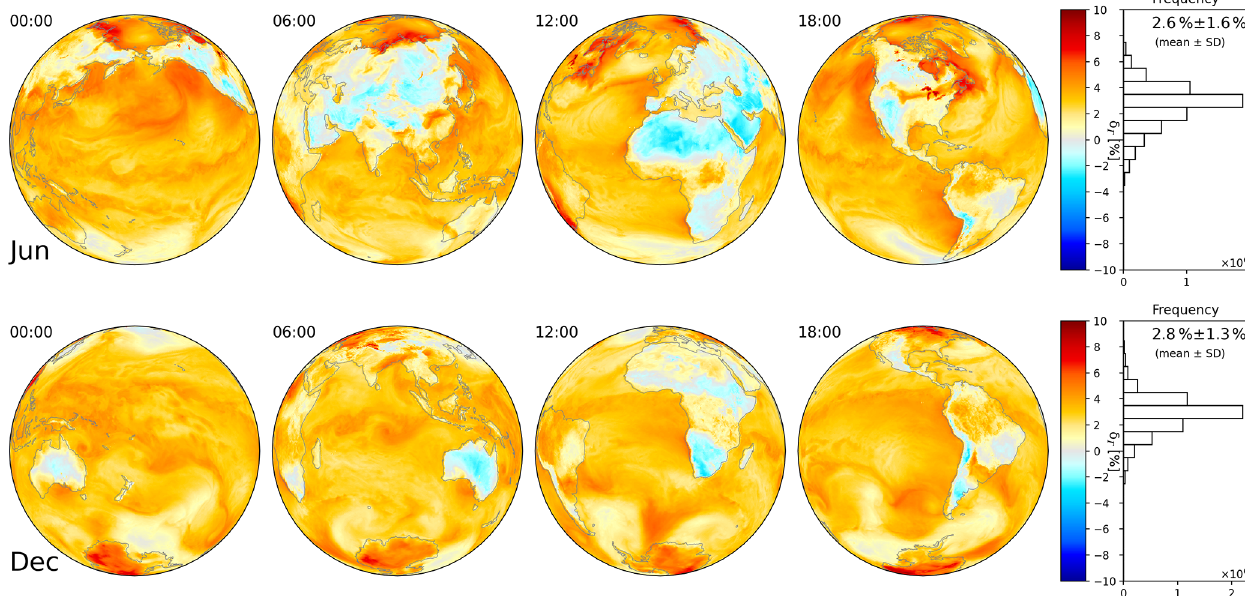
Figure 3. Deviation δ (cid:48) according to Eq. (19) for ERA5 at 00:00, 06:00, 12:00, and 18:00UTC on 18 June (top) and 18 December (bottom) 2018. The projection focuses on daytime for each time step. On the right, the frequency distribution and mean and SD are given for all hourly outputs of the respective day. Results for 18 March and 18 September 2018 are shown in Fig. C1.